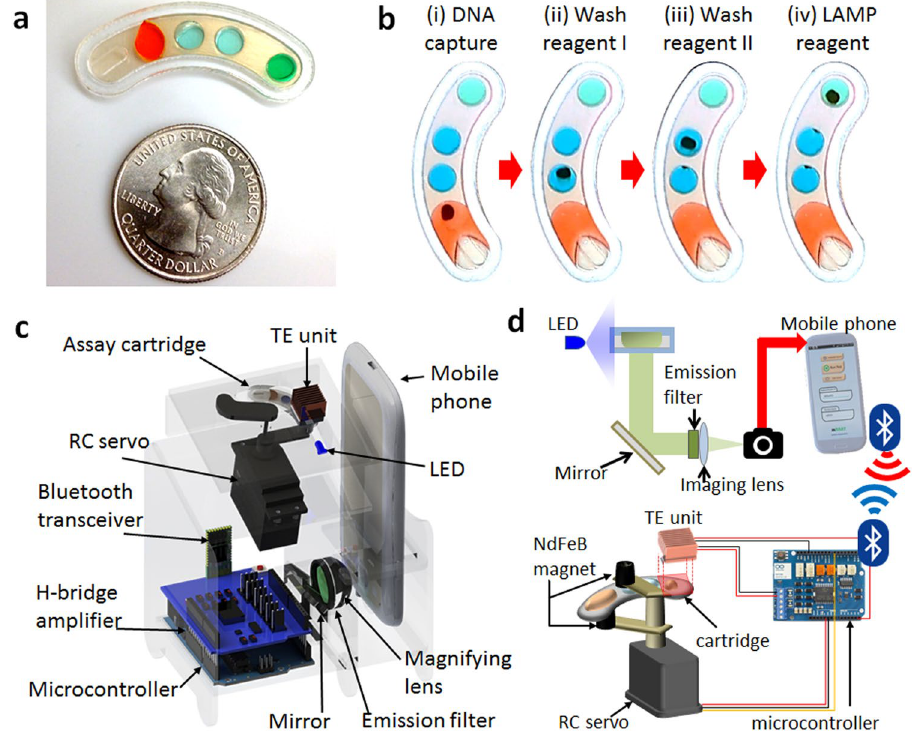
Figure 1. Technology overview. ( a ) Photograph of droplet magnetofluidic cartridge next to US quarter for comparison. ( b ) Time-lapse sequence of particle transport on cartridge. DNA is captured on the magnetic particle surface in (i), followed by successive rinsing steps in wash buffers (ii) and (iii), and subsequent elution and amplification in LAMP reagent (iv). ( c ) CAD layout of components inside the cartridge-processing